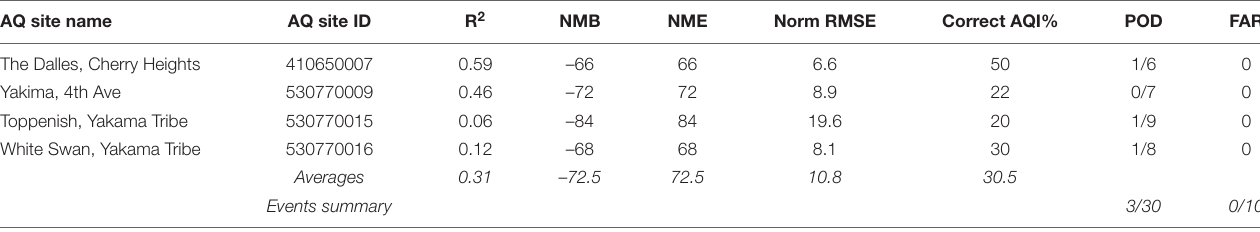
TABLE 6 | Same as Table 5 , but for the WRF-SFIRE-informed